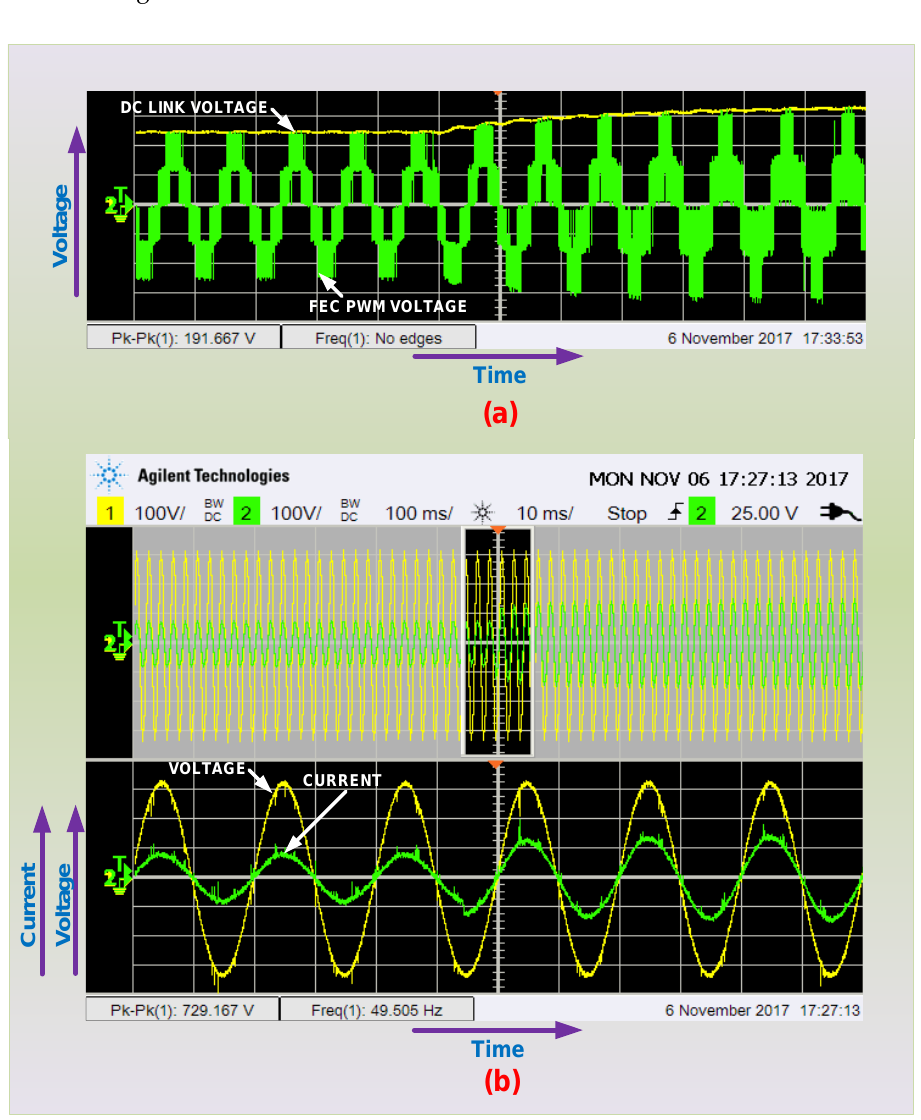
Figure 4. ( a ) Voltage and Current Waveforms of T-Type Front-End Converter ( b ) Input Voltage and Current Waveforms of Front-End Converter during Transition time for a step change in DC link voltage.